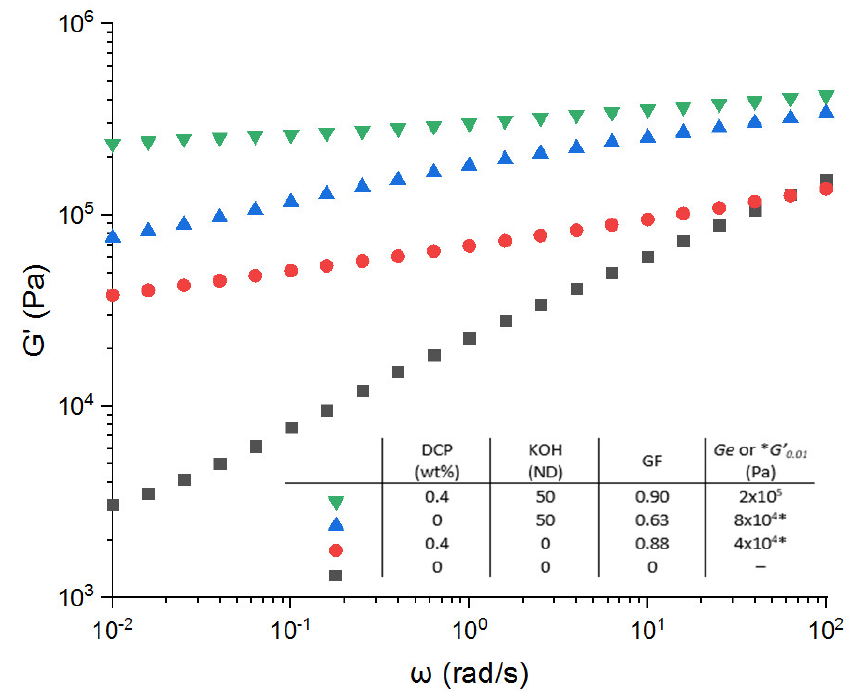
Figure 6. Variation of the storage modulus versus angular frequency. Comparison of the network types and influence of the combination of both ionic and covalent networks. * is G ′ 0 . 01 reported instead of Ge.